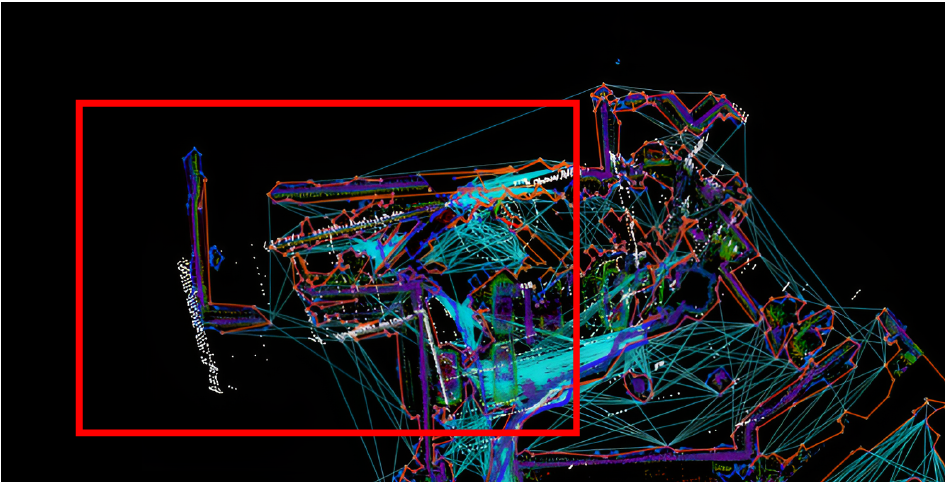
Figure 25. The unreliable